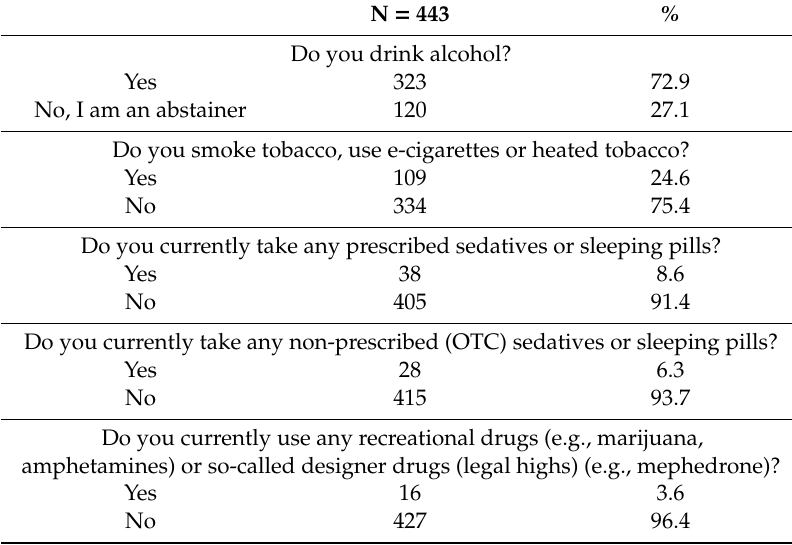
Table 2. Psychoactive / medicinal substance use and observed changes during the pandemic. N =